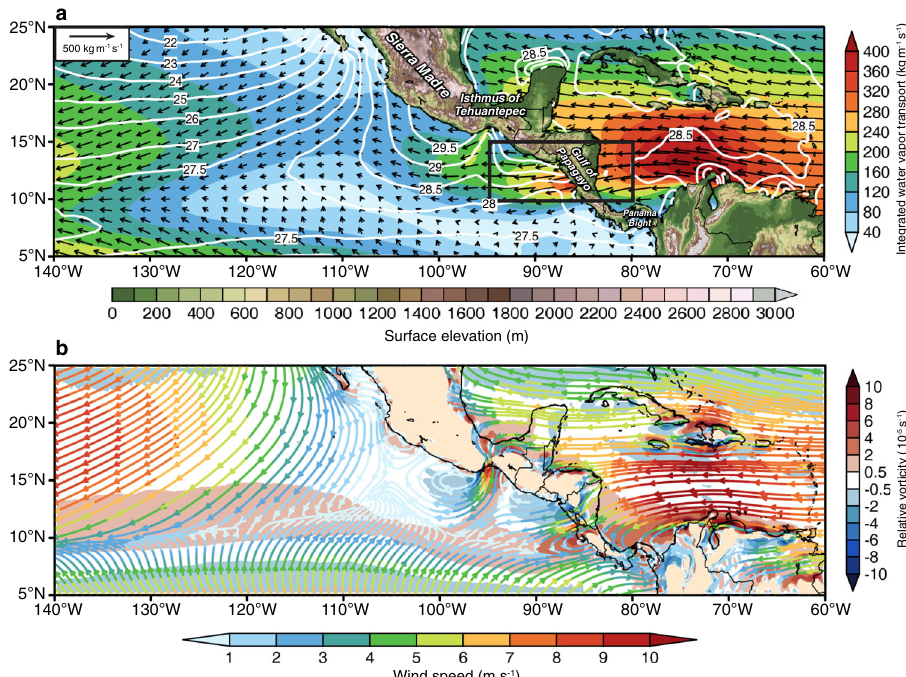
Fig. 1 Thermodynamic and dynamic climate mean states from the observations. a June – November 1990 – 2018 averaged NOAA Optimum Interpolation sea-surface temperature (NOAA OISST; °C) in white contours, ERA5 reanalysis data integrated water vapor transport magnitude (IVT; kg m − 1 s − 1 ) in color shadings (right color bar) and direction in vectors, overlaid with land surface elevation (m; bottom color bar). Black box (95°W – 80°W, 10°N – 15°N) illustrates the area of IVT intrabasin average in Fig. 6. b June – November 1990 – 2018 averaged ERA5 950 hPa relative vorticity (10 − 5 s − 1 ; right color bar) in color shadings, wind speed (m s − 1 ; bottom color bar) and wind direction in streamlines. Note that yellow areas over land in ( b ) indicate the mountain area at 950